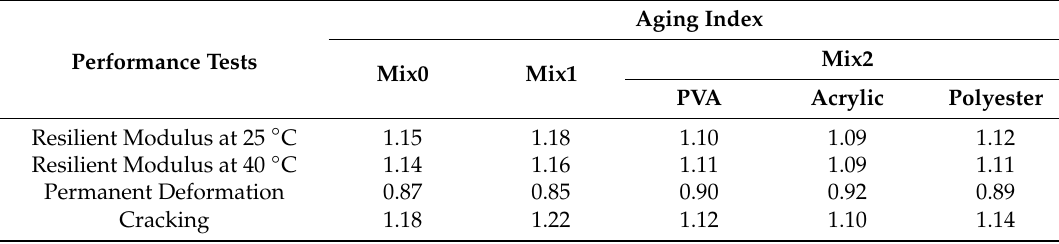
Table 5. Aging index of the asphalt mixtures.